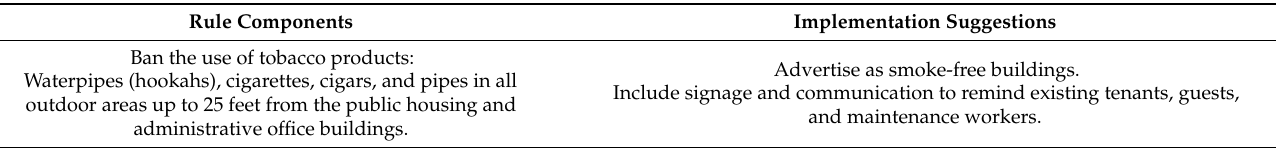
Table 1. Department of Housing and Urban Development smoke-free rule components and implementation suggestions. Rule Components Implementation